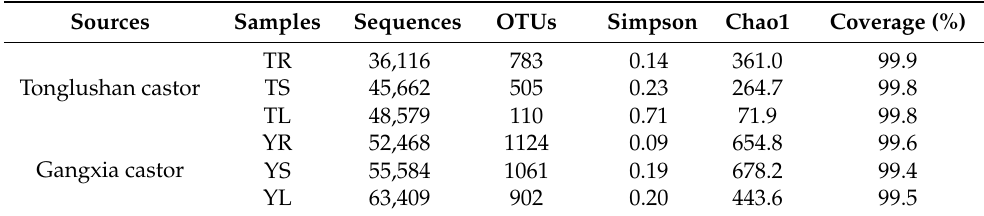
Table 2. Observed OTUs and Alpha diversity indices in Ricinus communis